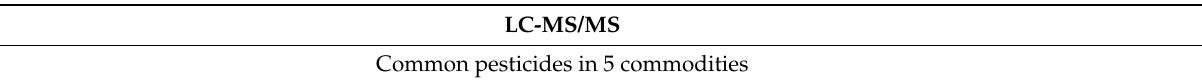
Table 7. Common validation pesticides in five fruits and vegetables which were studied for LC- MS/MS and GC-MS/MS analysis.